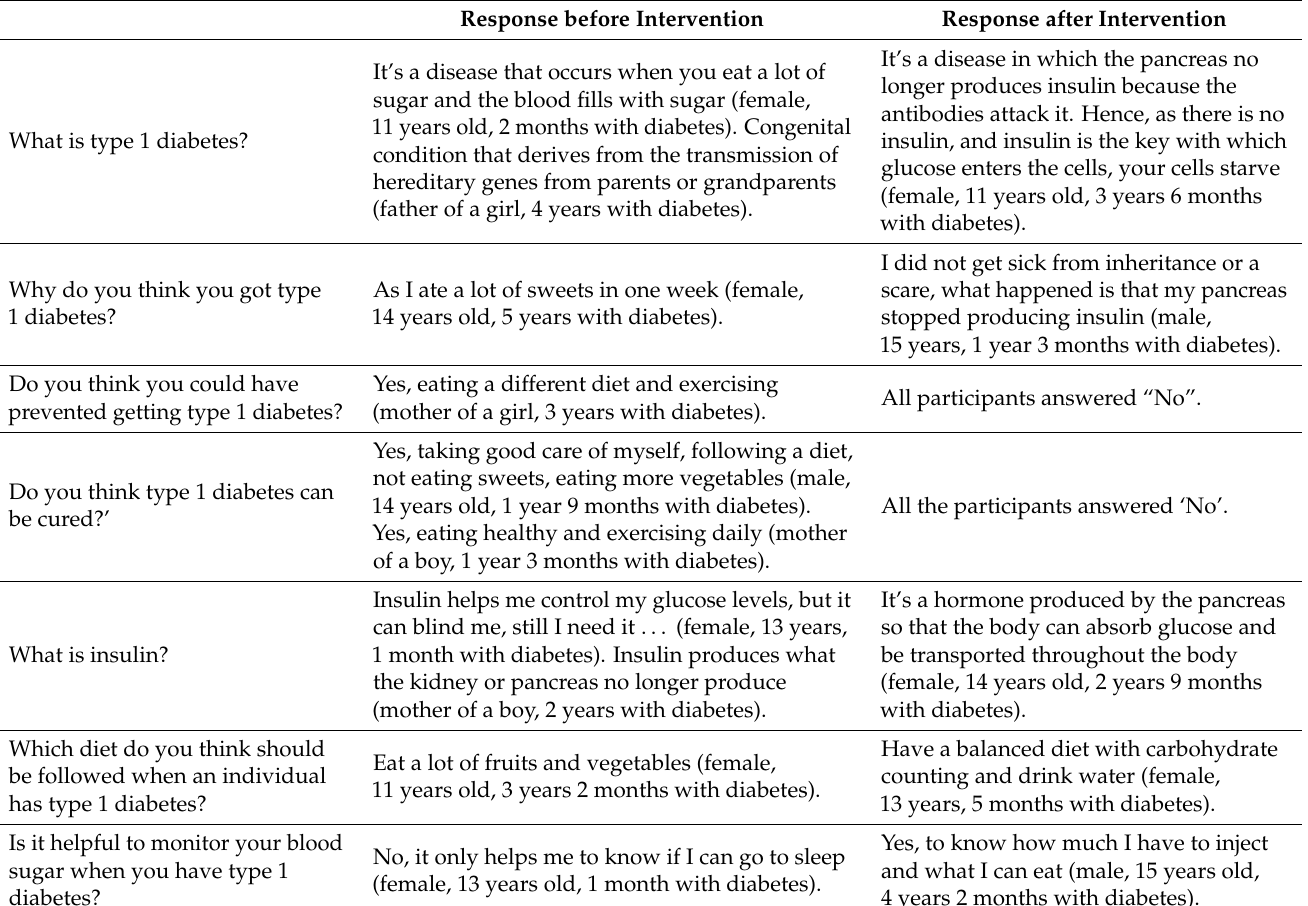
Table 6. Beliefs before and after the intervention. Response before